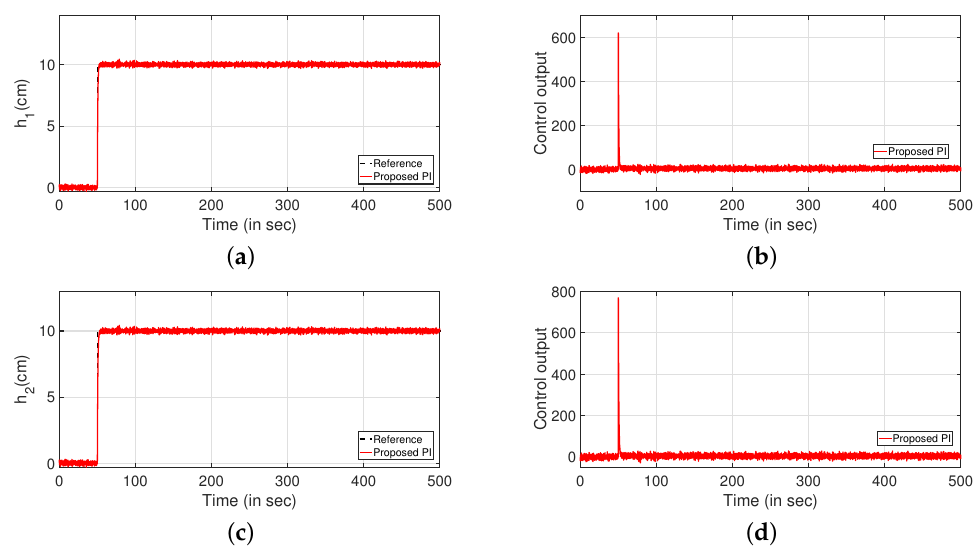
Figure 23. Reference tracking for PI controller with input uncertainties. ( a ) Level Variation in tank 1. ( b ) Control output. ( c ) Level Variation in tank 2. ( d ) Control output.